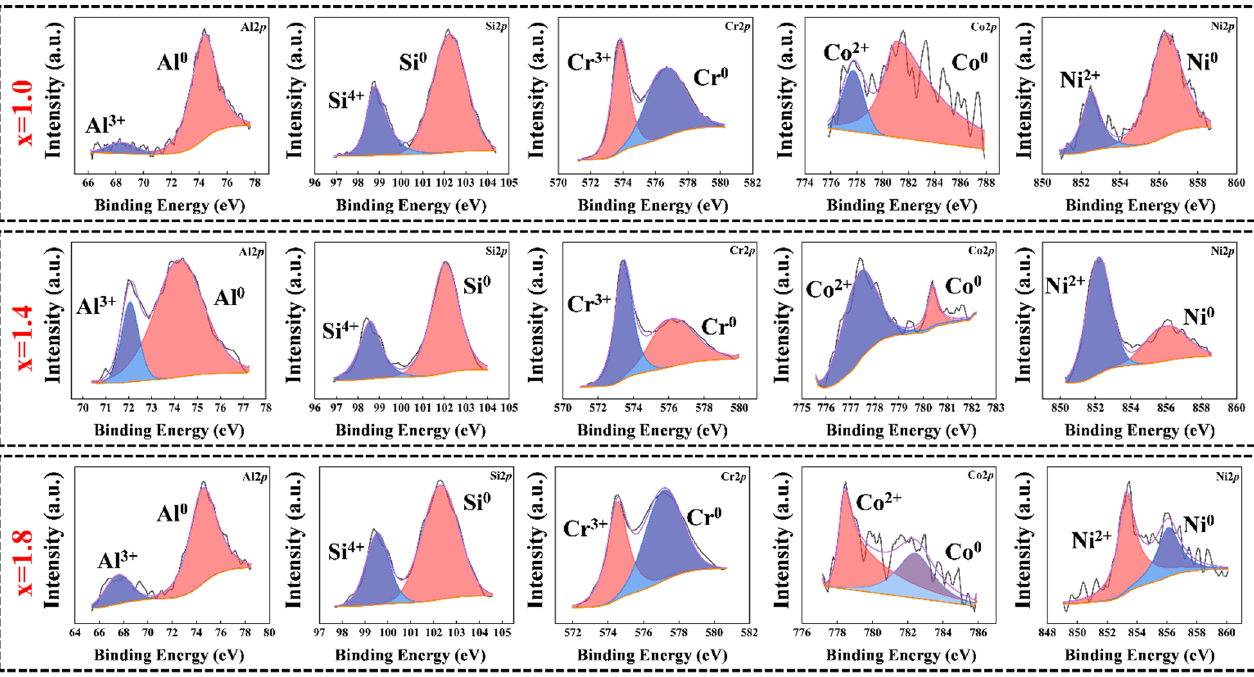
Figure 10. XPS semi-quantitative analysis for chemical compositions (at.%) for AlSi 0.5 Cr x Co 0.2 Ni high entropy alloys (x = 1.0, 1.4, and 1.6). 4. Conclusions While ensuring the high hardness as the premise, to further enhance the corrosion resistance of the lightweight Al-Si-Cr-Co-Ni high entropy alloy, the structural evolution and performance characterization of AlSi 0.5 Cr x Co 0.2 Ni (x = 1.0, 1.2, 1.4, 1.6, and 1.8) HEAs have been investigated. This work was indispensable to the development of lightweight engineering materials. The principal conclusions are summed up as follows: (1) AlSi 0.5 Cr x Co 0.2 Ni HEAs were formed of A2 (Cr-rich), B2 (Ni-Al), and Cr 3 Si phases; the saturation concentration of Cr 3 Si was about 27 at.%, as determined by XRD. The ad- dition of Cr could increase the crystallite size of HEAs. (2) With the addition of Cr content in the AlSi 0.5 Cr x Co 0.2 Ni HEAs, the dendrites became larger and the Cr 3 Si phase increased. Al, Co, and Ni tended to be enriched together, while Cr and Si were easy to form the Cr 3 Si phase.